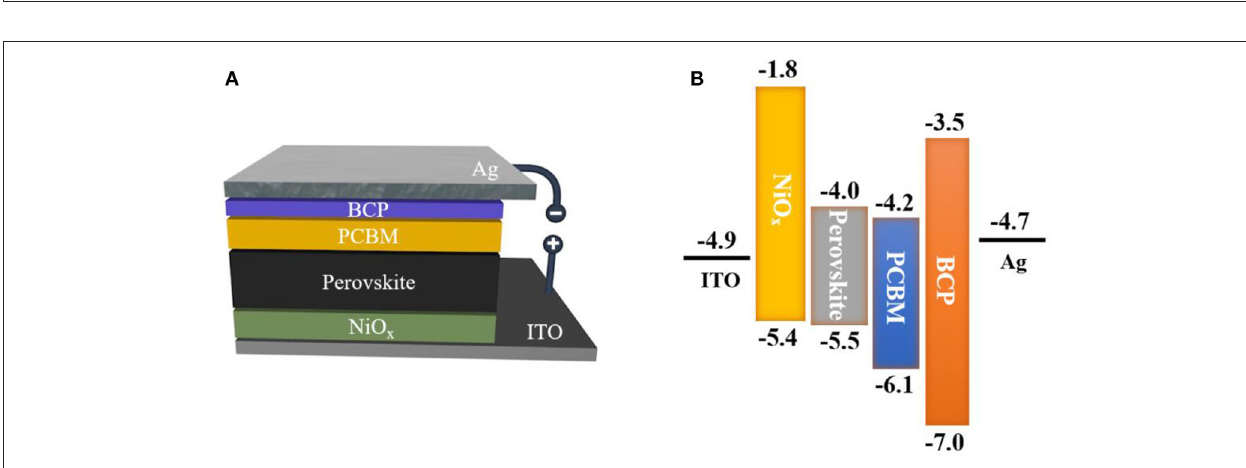
FIGURE 2 | SEM images of the (A) NiOx NCs, (B) the perovskite, and (C) the cross sectional SEM image of the inverted planar perovskite solar cell.